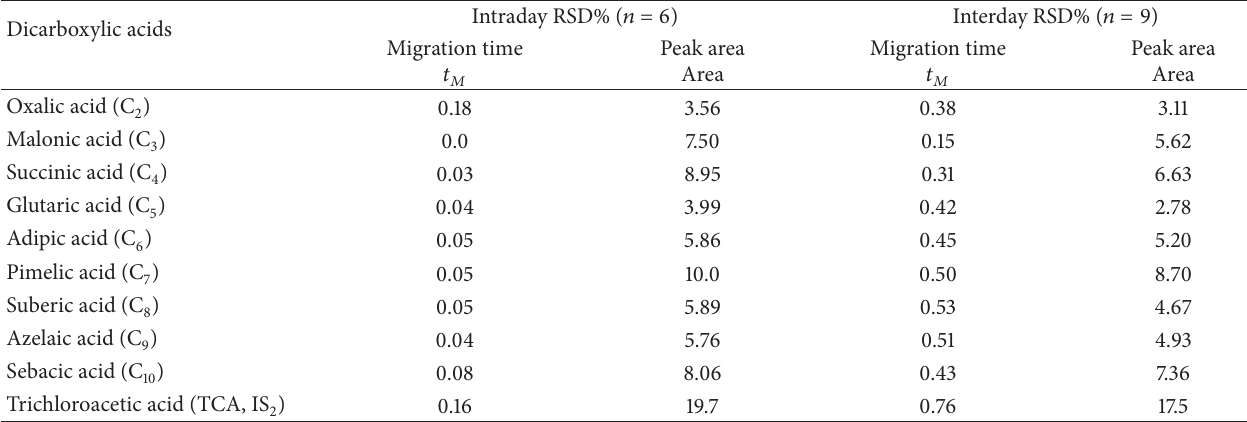
Figure 5: Electropherograms of (a) the air sample 2 and (b) the air sample 3 after solid-phase extraction. Sample collected with a cascade impactor (12 stages). The analyses were performed with two replicates and six repetitions. Electrolyte: 4mM PDA + 0.5 mM MTAH, pH 11.0; indirect detection at 310/266 nm; sample injection for 6 sec at 50 mbar; separation voltage − 24kV; analysis time 5 min. Analysis conditions as described in Experimental. Table 2: The intraday and interday results of the aerosol samples separated and determined under optimized capillary electrophoresis conditions (see Table